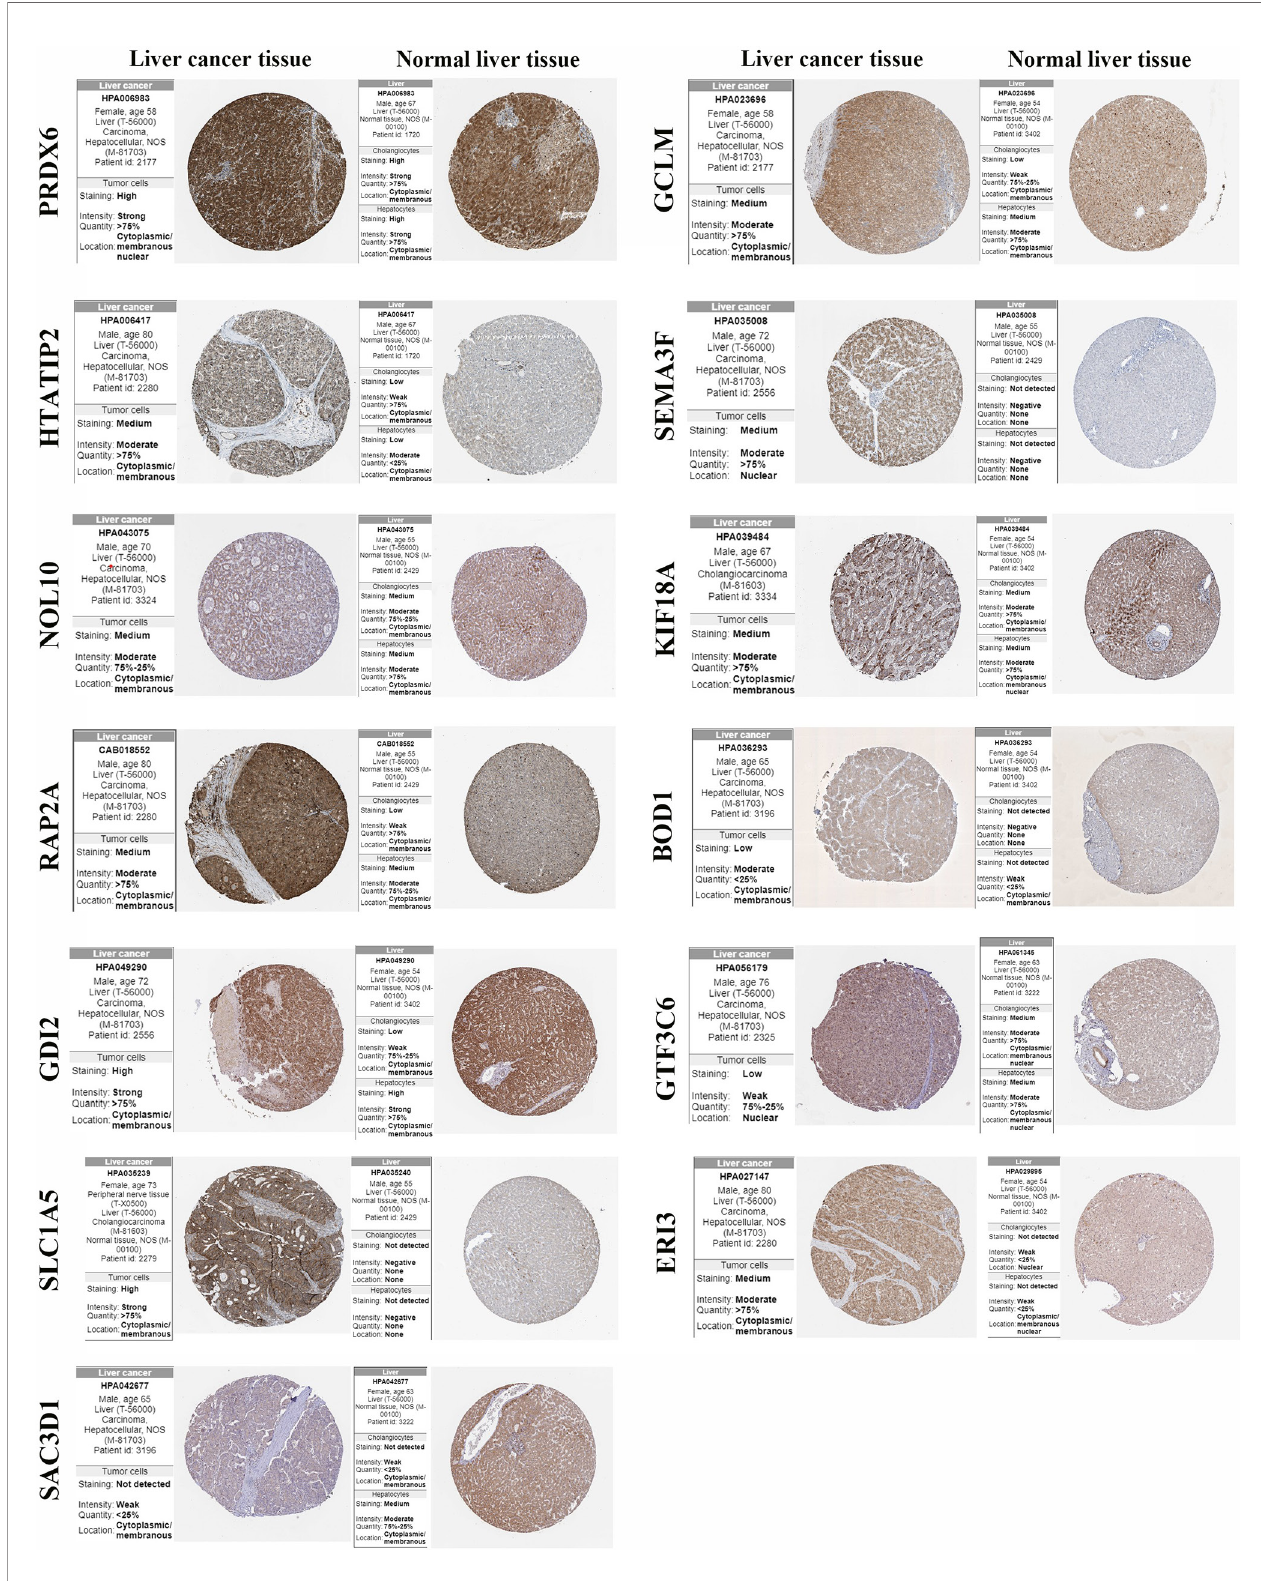
FIGURE 8 | Protein expression of gene signature in hepatocellular carcinoma tissue and normal liver